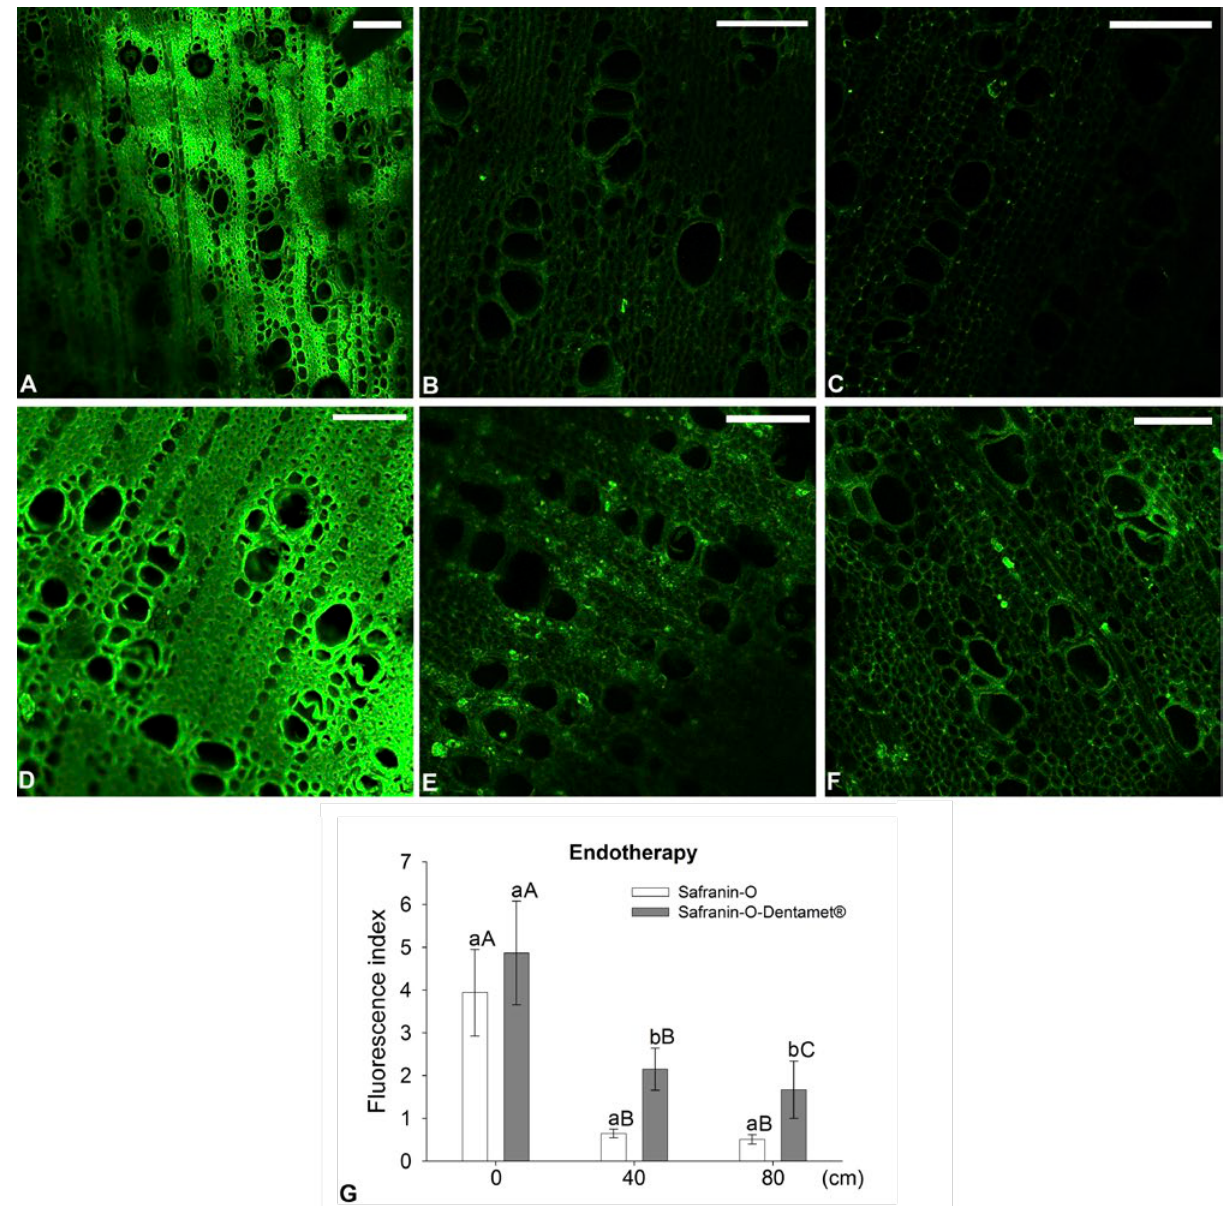
Figure 2. Confocal microscope images of transverse sections of olive cv. Ogliarola salentina healthy branches (approx. 10-year-old, 1 m length, 23-26 mm width) at 0 cm (A, D), 40 cm (B, E) or 80 cm (C, F) from the injection point of endo- therapy treatment with safranin-O (A-C),or with the mixture safranin-O/Dentamet® (D-F).Scale bars = 100 μm (A-F). (G) Fluorescence index of safranin-O quantified from confocal images of transverse sections of olive branch at 0 cm, 40 cm or 80 cm from the injection point of endotherapy treatment with safranin-O,or with the mixture safranin-O/Dentamet®. Data are means ± standard deviations of nine emission peaks per each endotherapy point. Different lowercase letters indicate significant differences between treatments for each distance from the injection points, uppercase letters indicate significant differences among the different distances within each treatment ( P